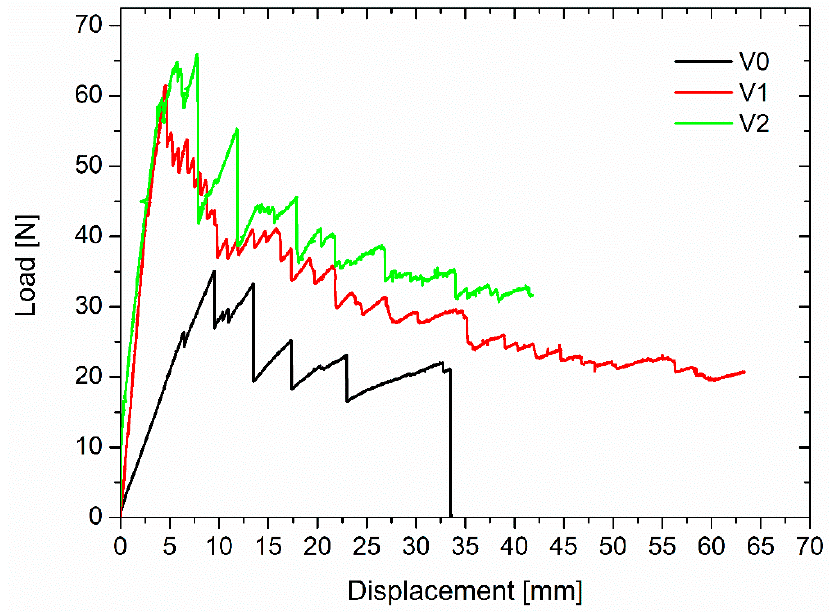
Figure 9. Typical load vs. deflection for the laminates modified with the soluble veils.